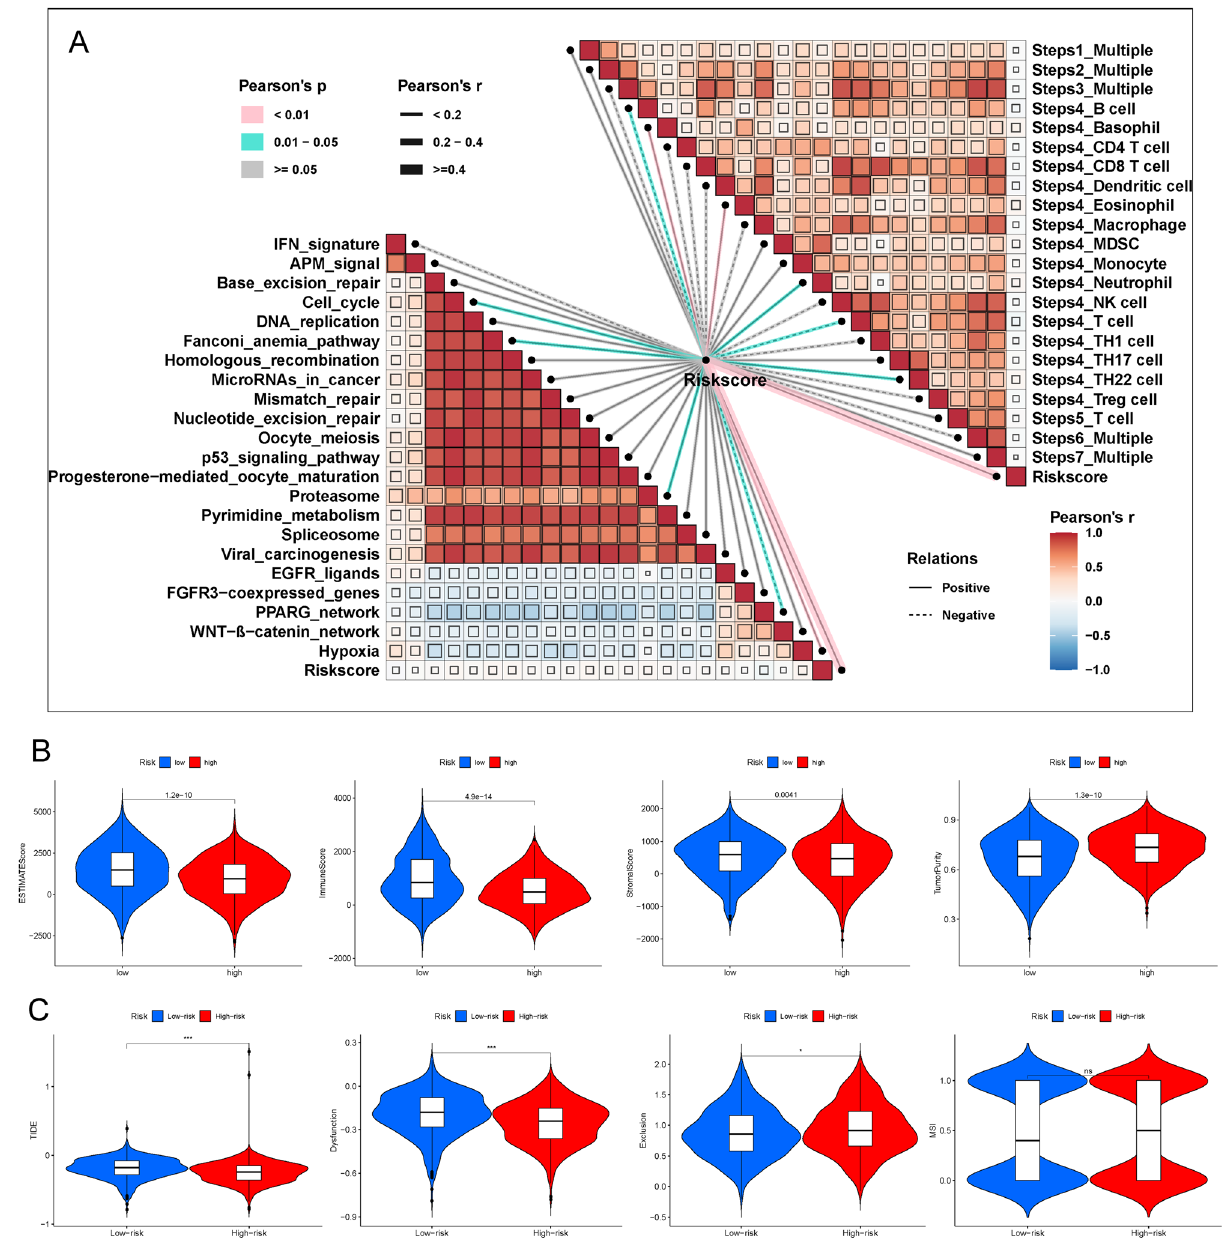
Figure 9. Analysis of immunotherapy effect. ( A ) Correlations between the risk score and enrichment score of the immunotherapy prediction pathway and hallmark gene set. The annotation of genes related cancer- immunity cycle was downloaded from Tracking Tumor Immunephenotype (http:// biocc. hrbmu. edu. cn/ TIP/ index. jsp). ( B ) The immune score, stromal score, tumour purity, and ESTIMATE score were used to quantify the distinct immune statuses between the high- and low-risk groups. ( C ) The Tumour Immune Dysfunction, and Exclusion (TIDE) algorithm was used to predict the immunotherapeutic benefit of The Cancer Genome Atlas (TCGA)-breast cancer (BC) patients. TIDE tumour immune dysfunction, and exclusion, TCGA The Cancer Genome Atlas, BC breast